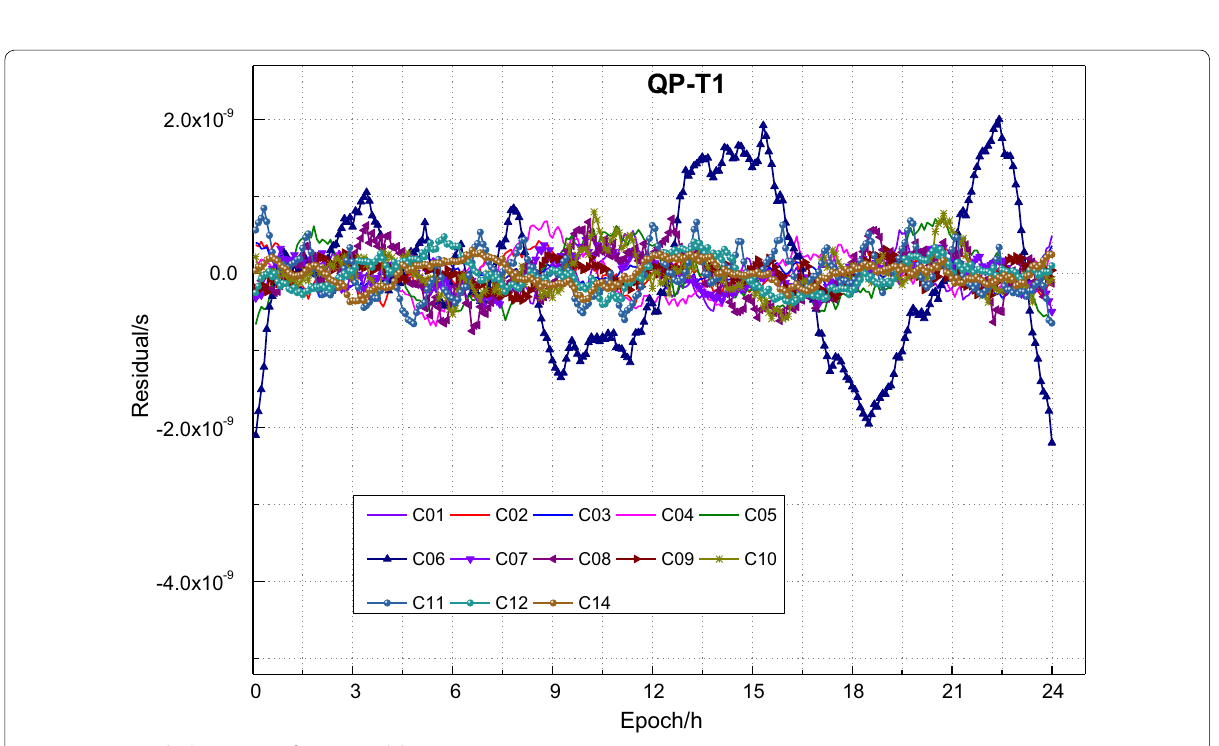
Fig. 1 Fitting residual sequence of QP model